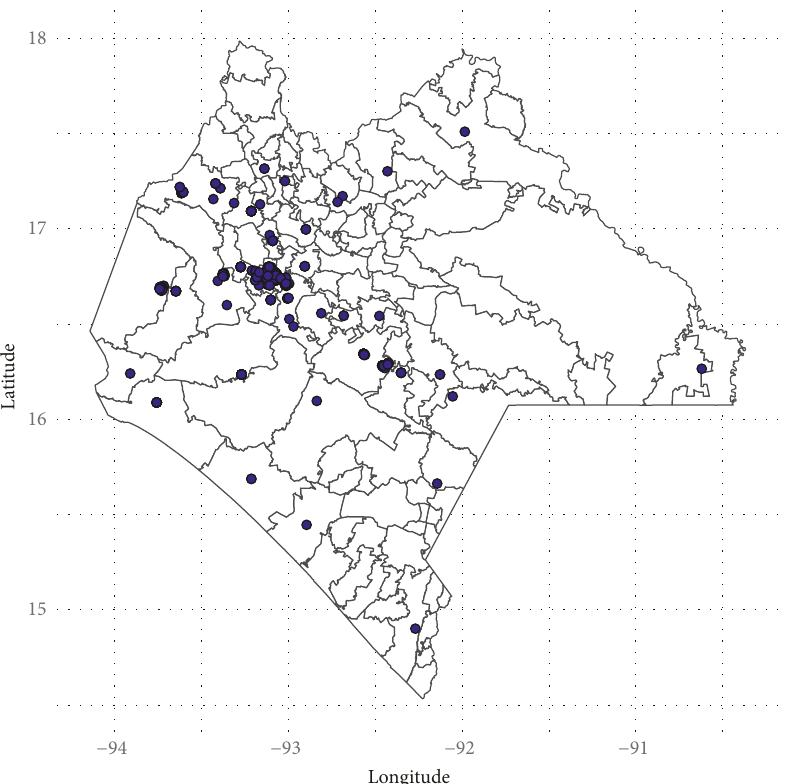
Figure 2: Spatial distributions of 573 cases of dengue confirmed in the state of Chiapas.